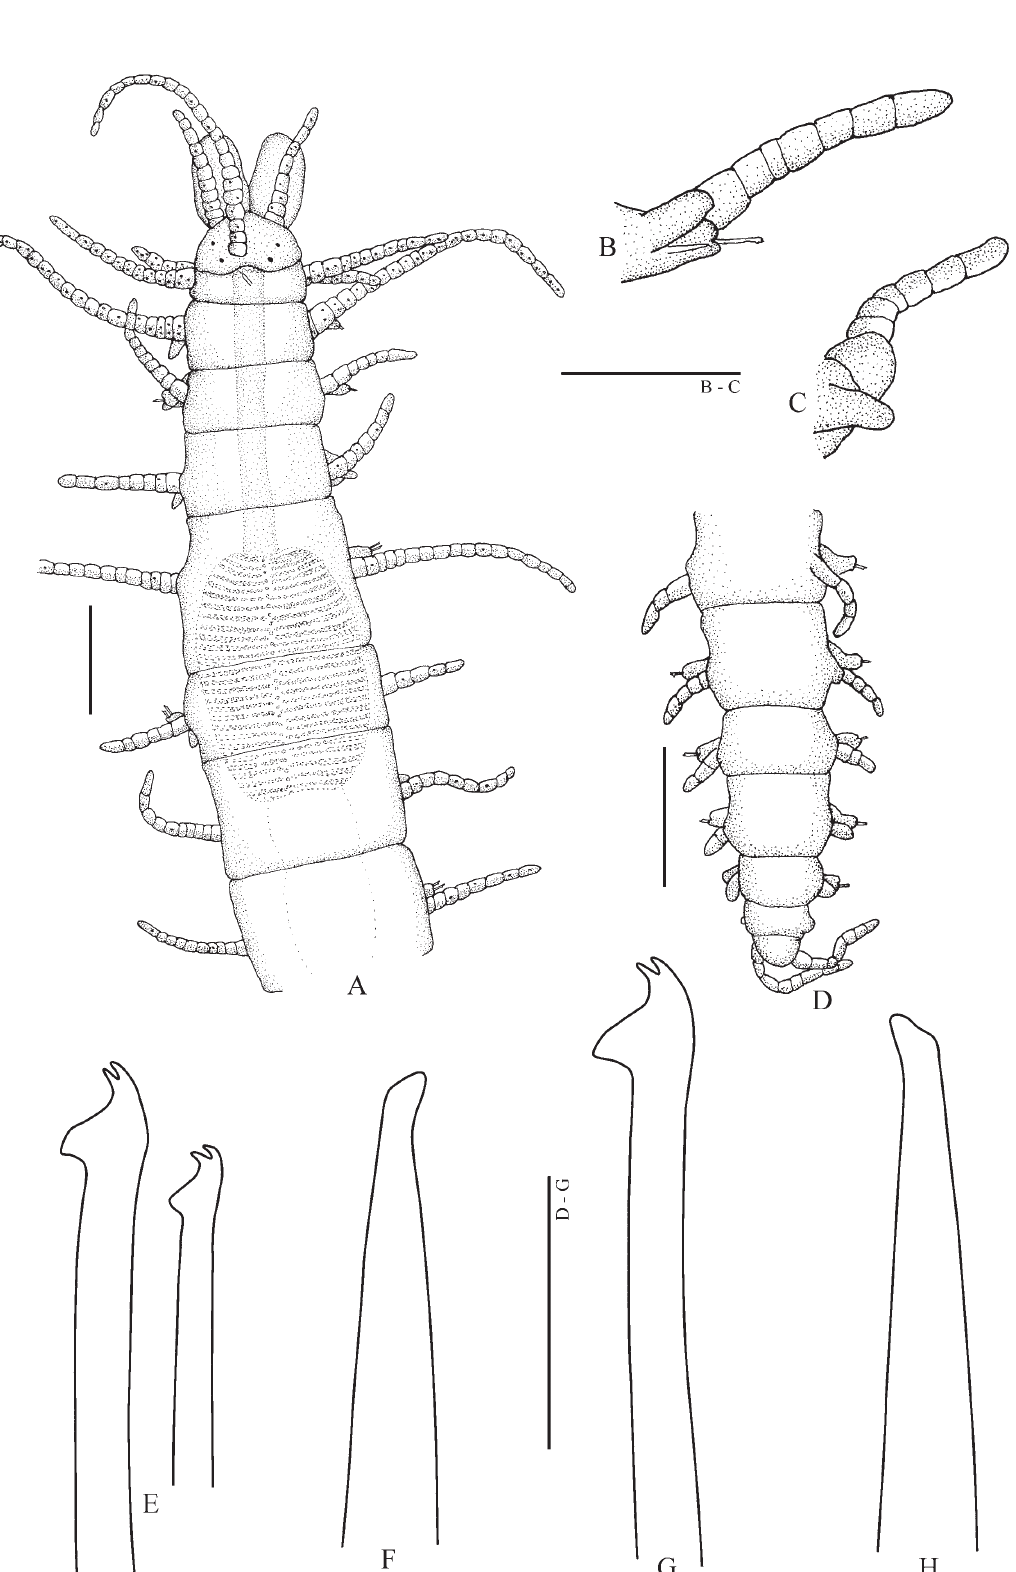
Fig . 13. – Hand-drawing of Haplosyllis navasi n. sp. A, anterior end, dorsal view. B, anterior parapodium, chaetiger 2. C, mid-body parapo- dium. D, posterior end, dorsal view. E, anterior chaetae, chaetiger 2. F, anterior acicula, chaetiger 2. G, mid-body chaeta. H, mid-body